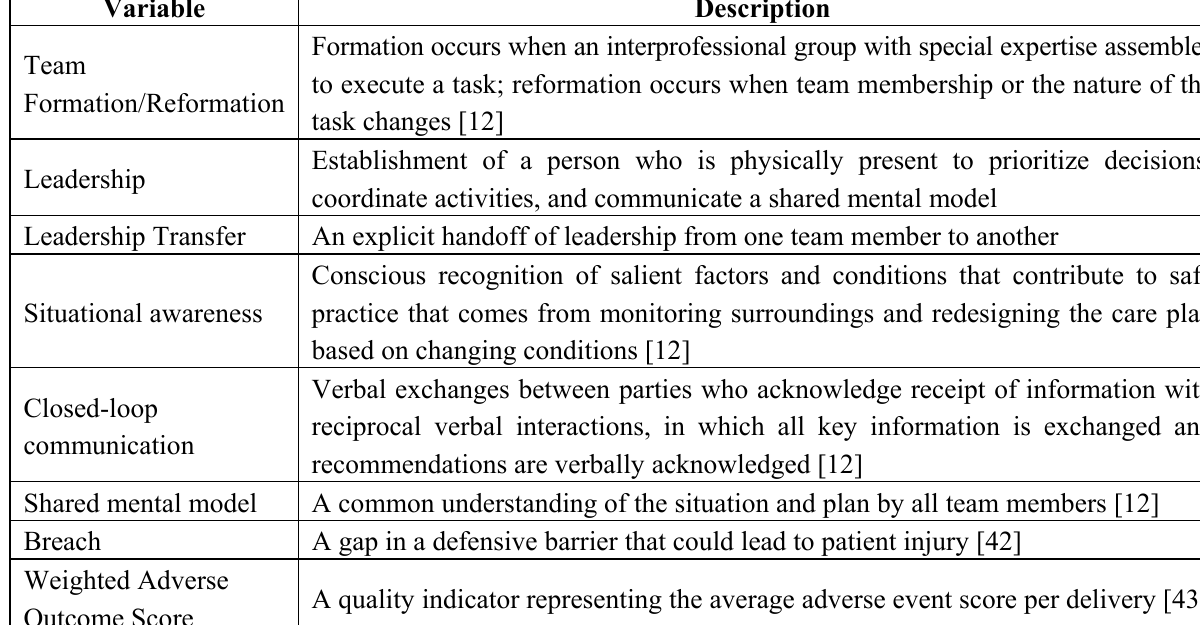
Table 4. Description of measured